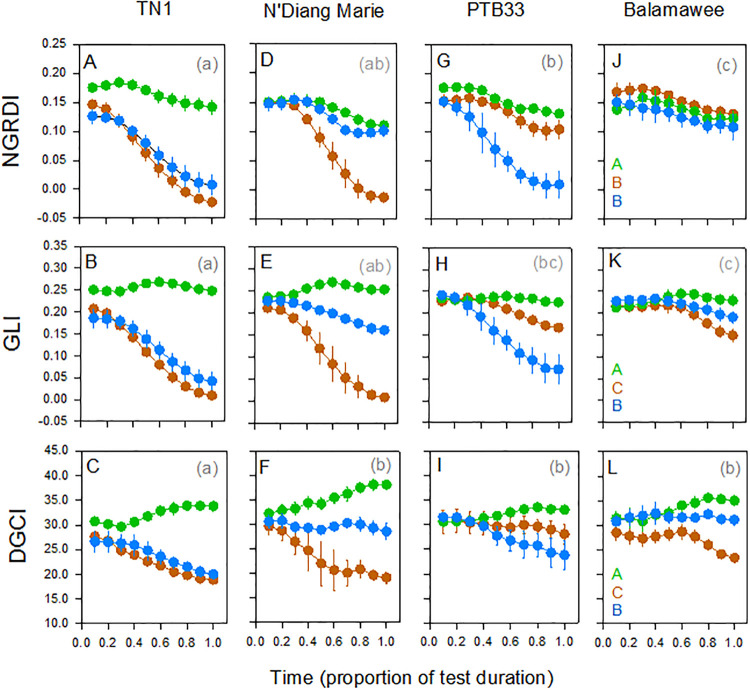
Changes in index values for control (green lines and symbols), brown planthopper-infested (brown lines and symbols) and whitebacked planthopper-infested (blue lines and symbols) seedlings of (A-C) TN1, (D-F) N’Diang Marie, (G-I) PTB33, and (J-L) Balamawee during Standard Seedling Seed-box Tests. Three indices are included as derived from mean red and green reflectance (NGRDI: A,D,G,J), mean red, green and blue reflectance (GLI: B,E,H,K) and hue-saturation-brightness (DGCI: C,F,I,L). Lower case letters indicate homogenous variety groups, uppercase letters indicate homogenous treatment groups (colours correspond with treatment symbols). Standard errors are indicated (N = 3).